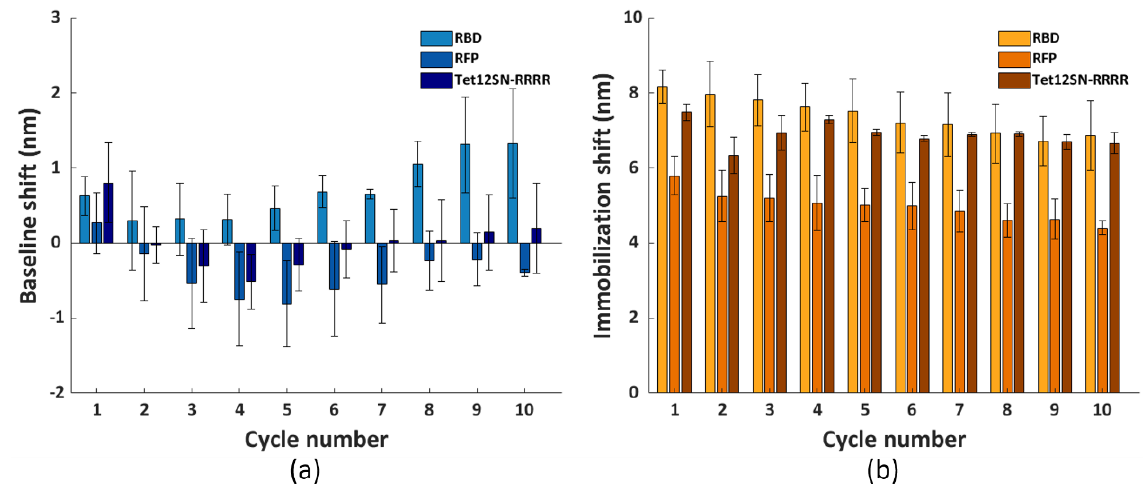
Figure 8. The ( a ) baseline and ( b ) immobilization shifts for each cycle, obtained with immobilizing RBD, RFP and Tet12SN−RRRR at 20 μg/mL. The surface regeneration was performed using condition G and washing with 0.5 M NaOH for 3 min, for a total of ten cycles. Each bar represents the average value from two parallel measurements performed on two different FO sensor probes, with error bars being standard deviations (n s = 2).